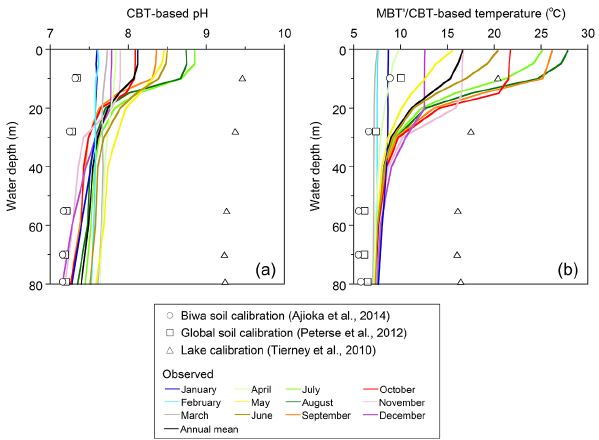
Figure 5. Reconstructed water pH (a) and MBT 0 /CBT-based tem- perature (b) for Lake Biwa surface clays (Ajioka et al.,